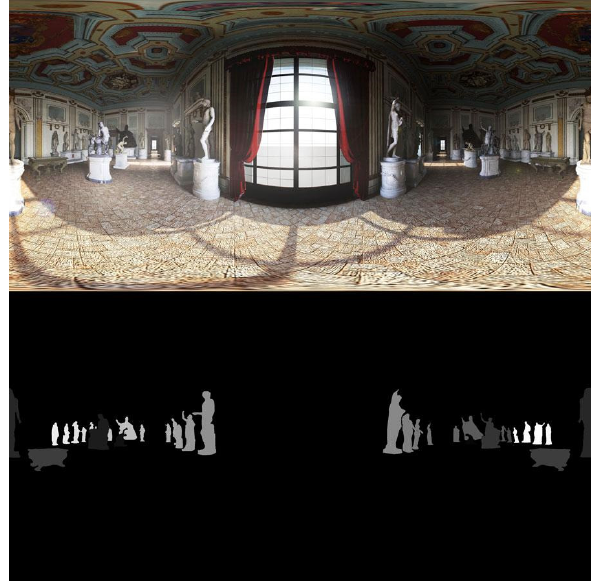
Figure 11. Panoramic rendering for base color (top) and encoded semantic masks (bottom).